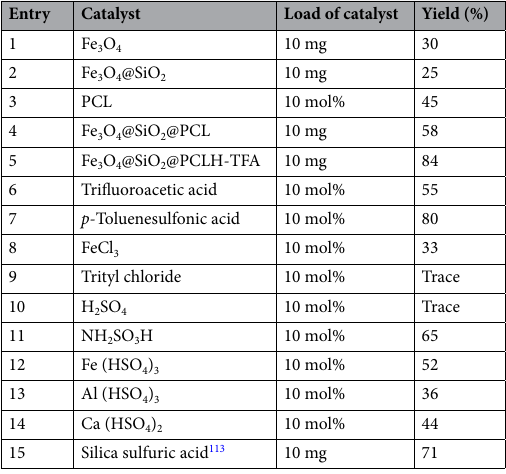
Table 2. Investigation of catalytic behavior of Fe 3 O 4 @SiO 2 @PCLH-TFA and its relative intermediates and some known catalysts upon the synthesis of 1f. Reaction conditions: 4-Cholorobenzaldehyde (1